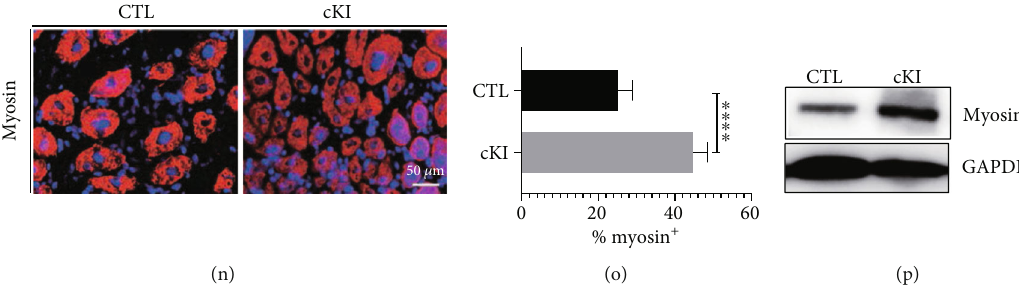
Figure 3: METTL3 conditional knockin promotes muscle regeneration in vivo . (a) Schematic outline of CTX injection in TAM-treated control and METTL3 cKI littermates at the age of 8 – 9 weeks. (b) H&E staining of representative tibialis muscle sections from METTL3 cKI, control mice treated 2, 5, and 8 days after CTX injection. (c) Quanti fi ed of muscle fi bers. (d) The upregulation e ff ect of METTL3 was veri fi ed at protein levels by Western blot. (e, h, k) Immunohistochemical and (n) immuno fl uorescence staining of TA muscle from METTL3 cKI and control detected by Pax7, Ki67, myogenin, and myosin antibodies. (f, i, l, o) Quanti fi cations of Pax7+, Ki67+, myogenin +, and myosin+ cells were shown on the right. (g, j, m, p) Western blot detected the protein expression levels of Pax7+, Ki67+, myogenin, and myosin. Data represent mean ± SEM . N = 5 . ∗∗∗∗ p < 0 : 0001 , ∗∗ p < 0 : 01 , ∗ p < 0 : 05 . CTX: cardiotoxin; TAM: tamoxifen; TA: tibialis anterior; CTL: control; cKI: METTL3 conditional